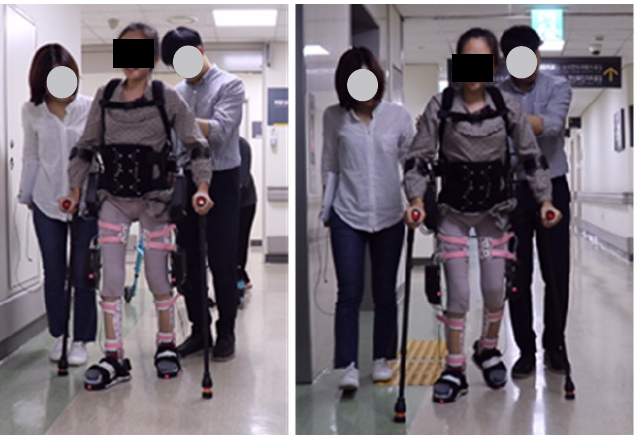
Figure 14. Walking trial of a patient with spina bifida wearing Angel Legs and using bilateral forearm crutches.